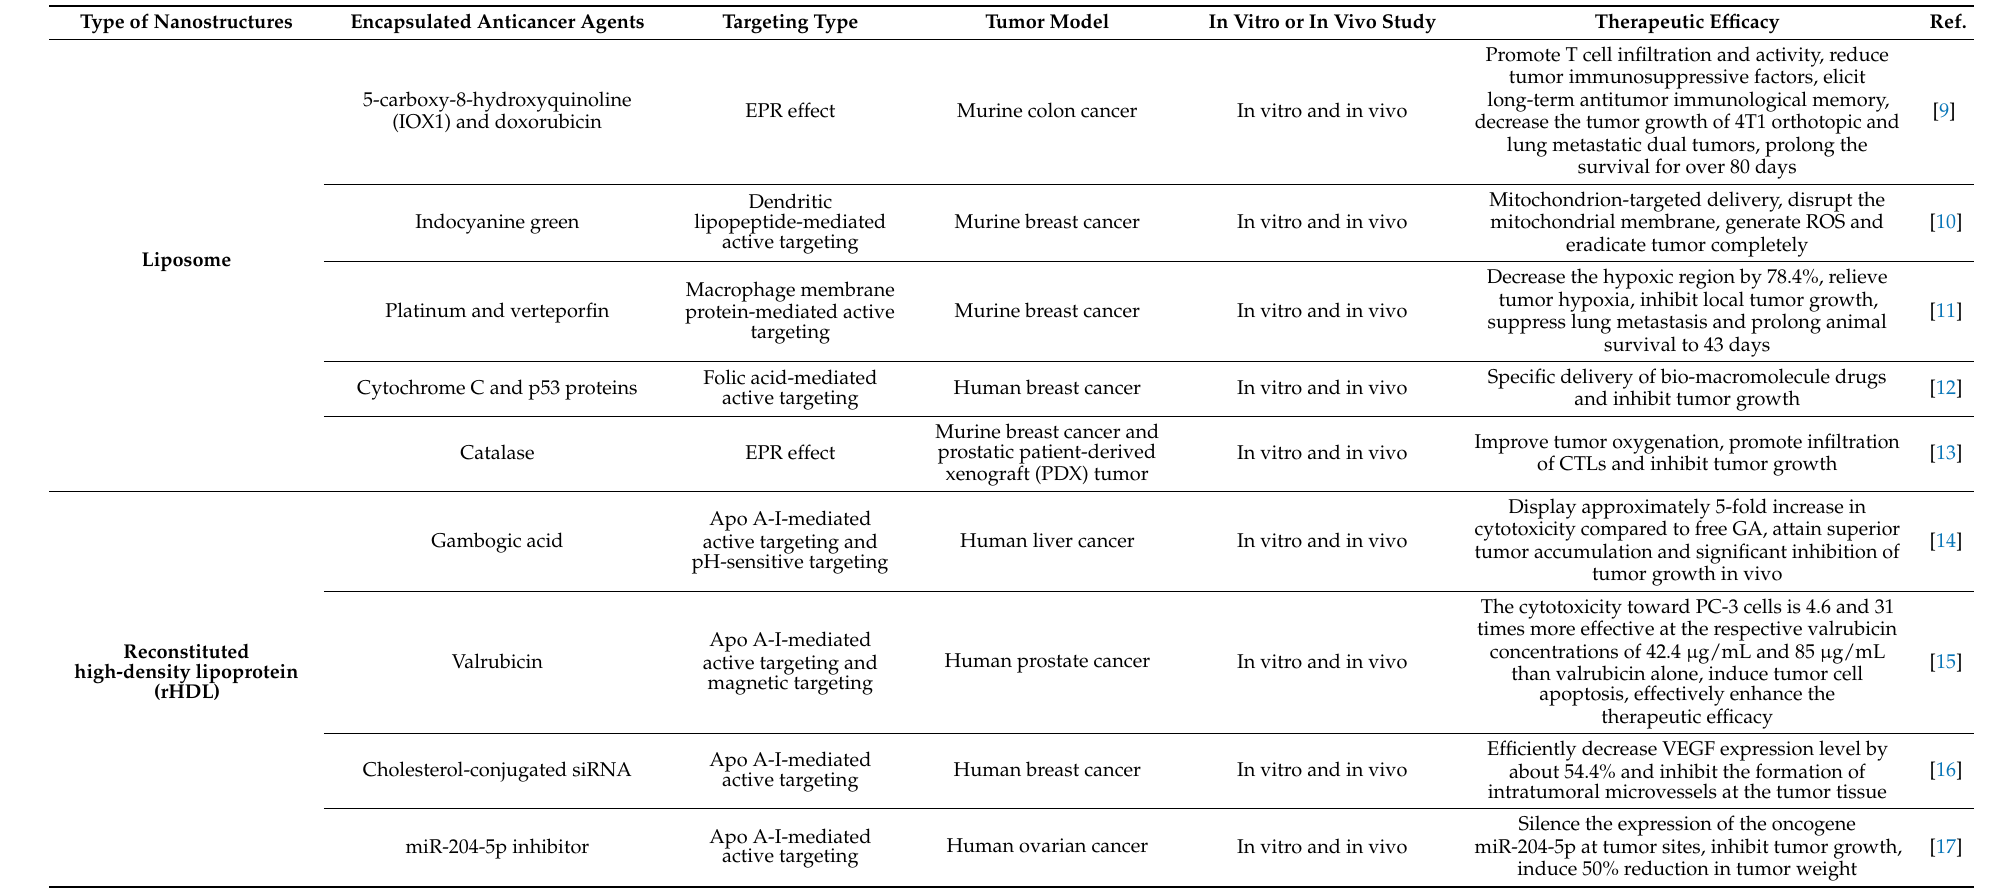
Table 1. Summary of various nanostructures to encapsulate therapeutic agents in anticancer targeted drug